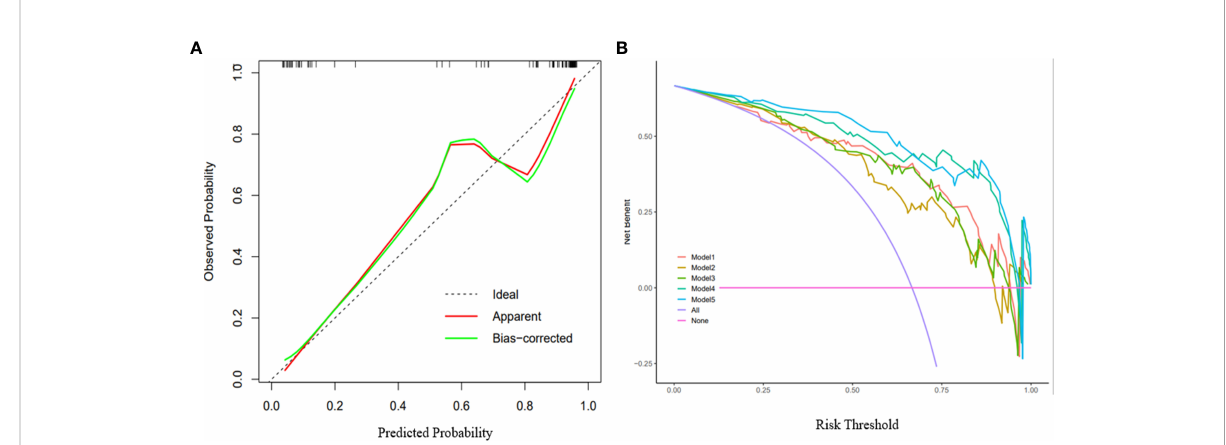
FIGURE 5 Calibration curves and decision curve analysis of the nomogram. (A) Calibration curves of the nomogram: The X-axis represented the predicted probability estimated by nomogram, whereas the Y-axis represented the actual observed rates. the red line represented the apparent prediction of nomogram, the green line represented the fi tting line after bias-corrected. the dashed line represented the ideal estimation. Calibration curves showed the actual probability is relatively close to the prediction of nomogram. (B) Decision curve analysis for the models 1-5: The X- axis represented the threshold probability that was where the expected bene fi t of treatment was equal to the expected bene fi t of avoiding treatment. The Y-axis represented the net bene fi t. The purple line represents the hypothesis that all patients are ADC, and the red line represents the hypothesis that all patients are SCC. Other curves are shown in the fi gure, representing models 1-5 in